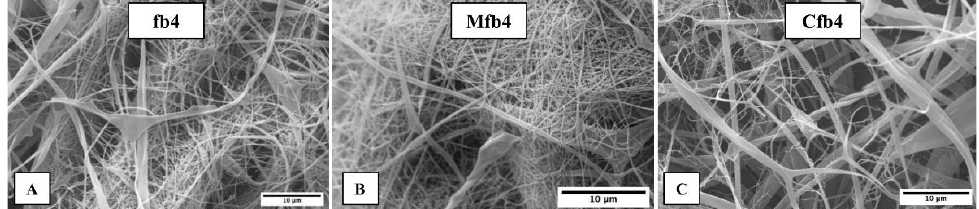
Figure 1 . SEM photographs of ( A ) placebo HPMC-AS912 and HPMC K100LV electrospun fibers (fb4); ( B ) meloxicam loaded fb4 electrospun fibers (Mfb4); ( C ) carvedilol loaded fb4 electrospun fibers (Cfb4).